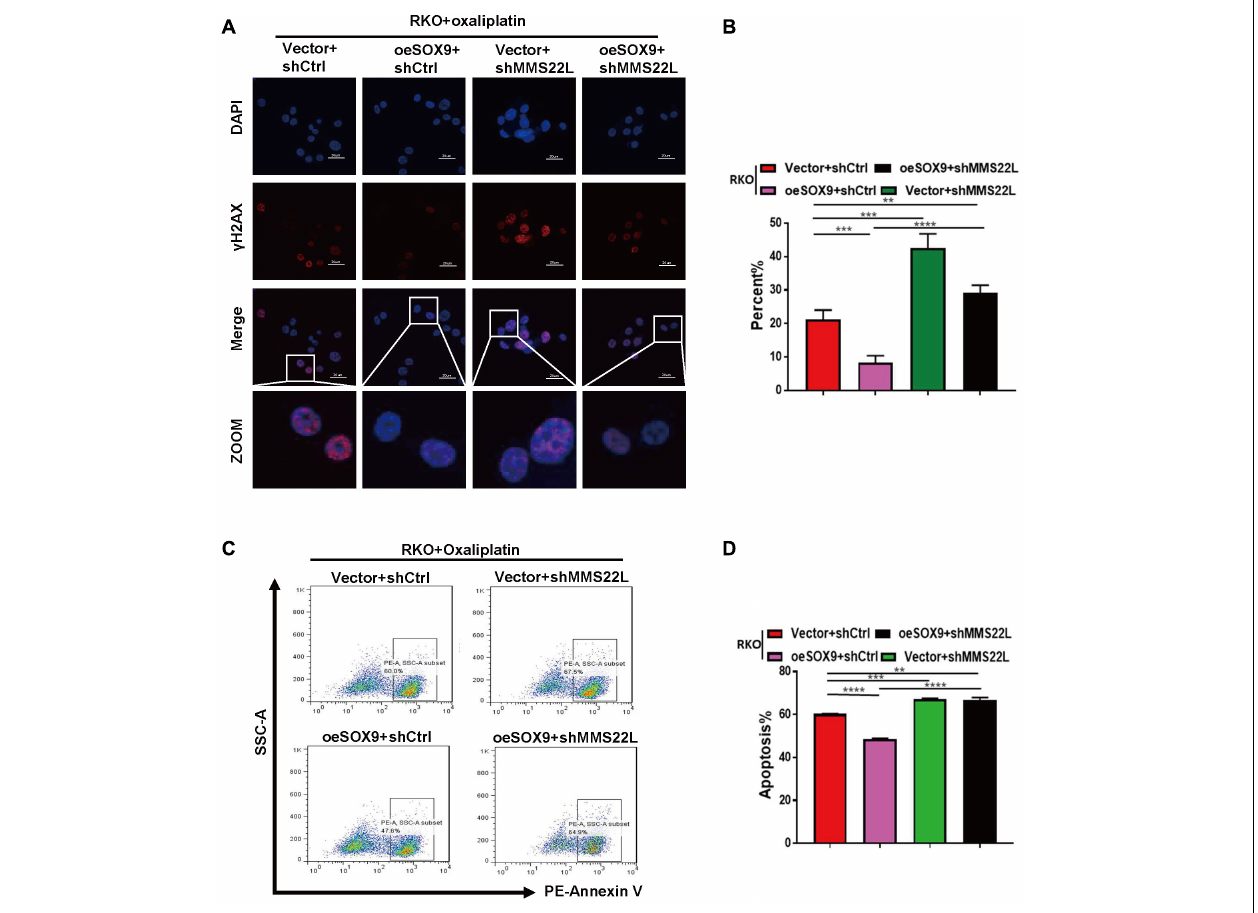
FIGURE 4 | Loss of MMS22L enhances chemosensitivity in SOX9-overexpressing CRC cells. (A,B) Immunofluorescence images showing the typical appearance (A) and percentages (B) of γ H2AX-positive cells in the indicated groups; nuclei were stained with DAPI (blue). Scale bar = 20 µ m. (C,D) Flow cytometry results showing early apoptosis and the percentage of apoptotic cells among Vector+shCtrl, oeSOX9+shCtrl, Vector+shMMS22L, and oeSOX9+shMMS22L cells treated with oxaliplatin. ** p < 0.01; *** p < 0.001; and **** p < 0.0001.